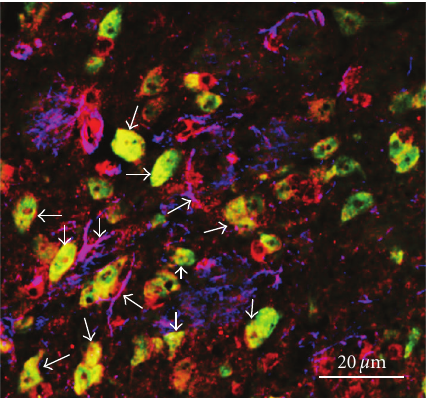
Figure 1: (Pro)renin receptor expression in the C57Bl/6J mouse brain. Triple immunofluorescence staining for PRR (red), neuron- specific nuclear protein (green, neuron marker), and glial fibrillary acidic protein (blue, astroglia marker) revealed that PRR is expressed in both neurons and astroglia with prominent expression in the neurons. Arrows indicate the colocalization of PRR with neurons or astroglia.